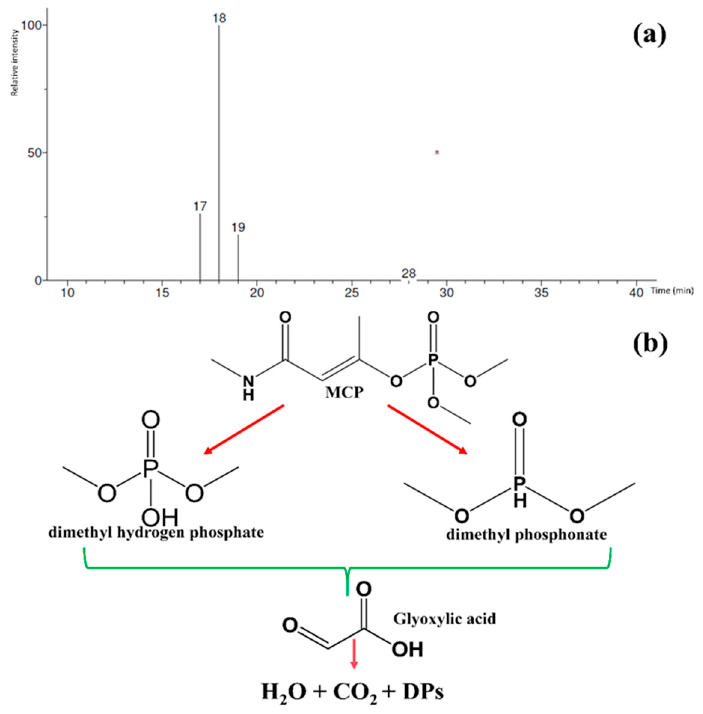
Figure 12. ( a ) GC-MS mass spectra of MCP degradation and ( b ) the possible degradation pathways of MCP pesticides .